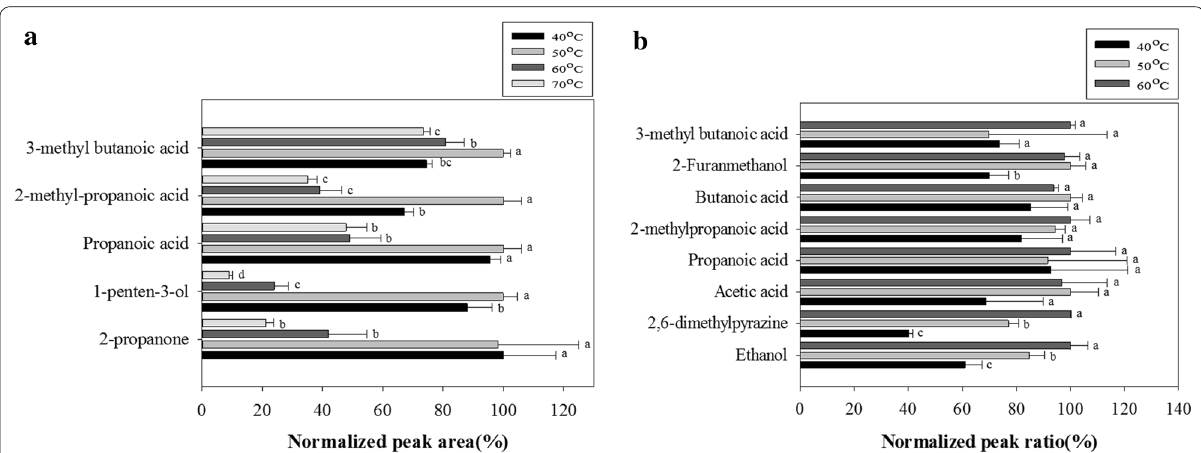
Fig. 3 Effect of extraction temperature using a SPME and b SPME‑Arrow methods for the extraction of volatile compounds in fish sauce ( p < 0.05)